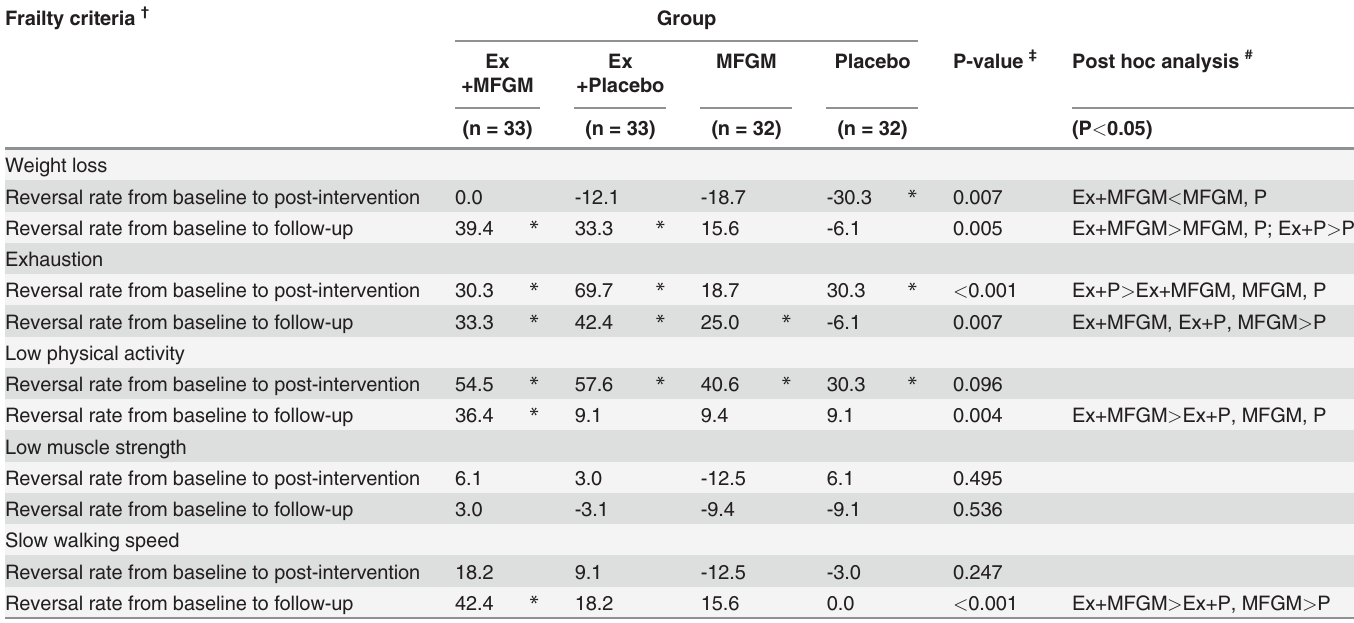
Table 3. Effects of the intervention on each frailty criteria between baseline, post-intervention and